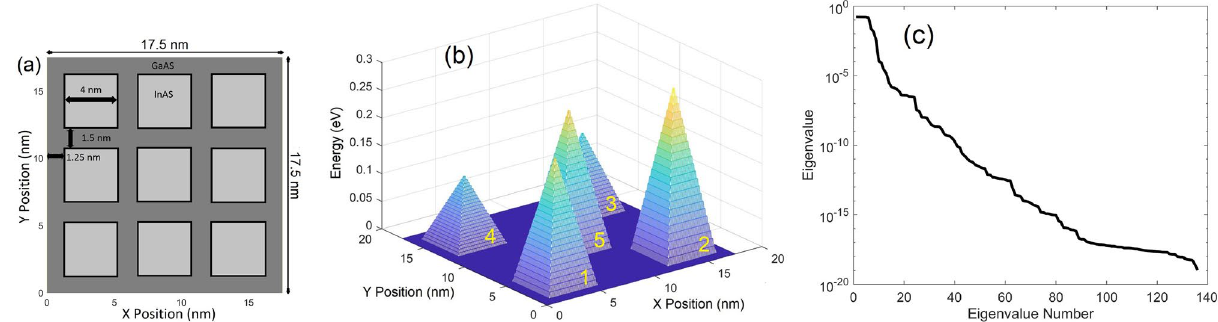
Figure 7. ( a ) GaAs/InAs QD structure with periodic BCs. ( b ) Potential energy with a profile of 5 pyramids applied to the QD structure in ( a ). ( c ) Eigenvalue of WF data in descending order.